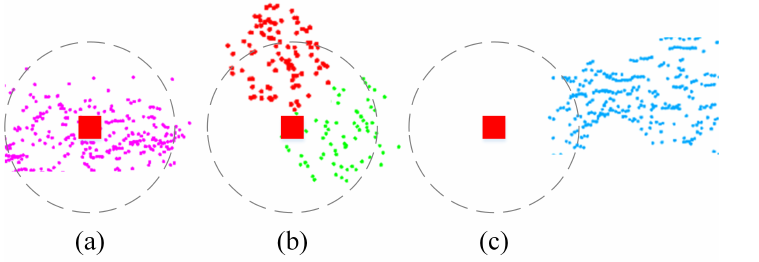
Figure 6. Radar measurement filtering using point cloud-based verification. ( a ) The mmW-radar target (red square) is valid as there are enough LiDAR points around it and the centroid of the segment is close enough to the radar target. ( b ) Two segmented objects are considered corresponding to the radar target. ( c ) Ghost target as the LiDAR point number in the specified radius is small and the point cluster is far from the